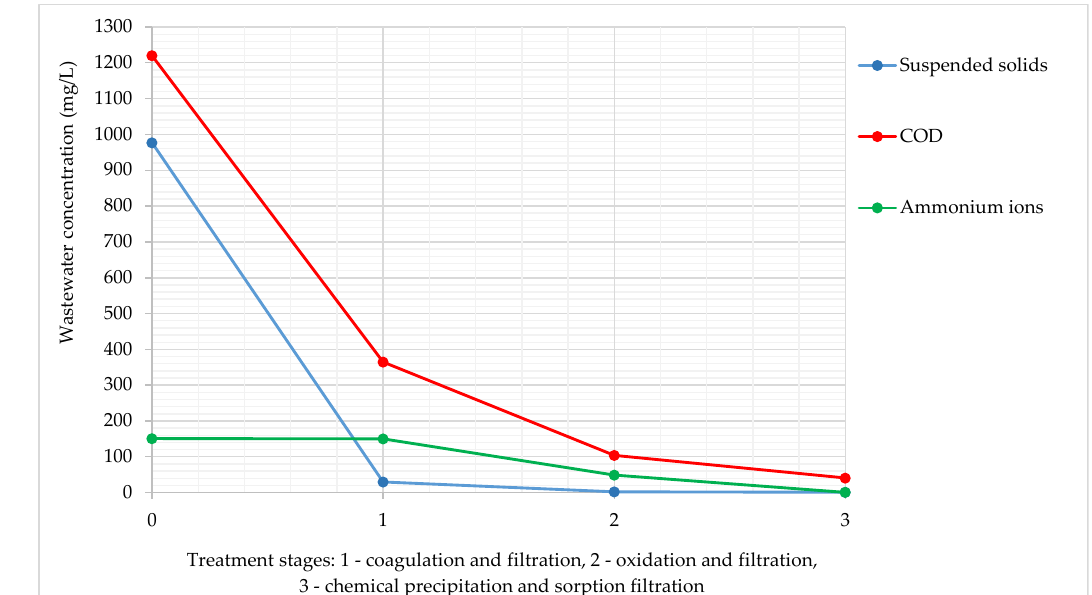
Figure 2. Changes of wastewater concentration at different treatment stages during experiments in the